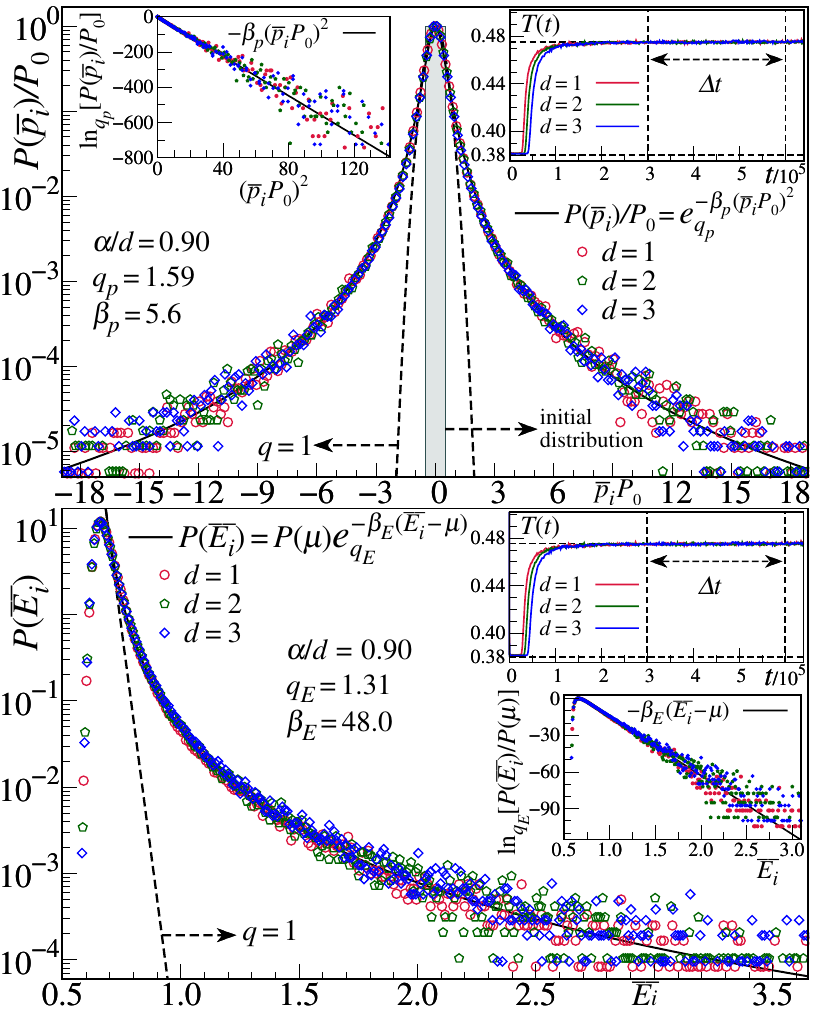
Figure 14. Distributions of the time-averages of the momenta ¯ p i and of the energies ¯ E i (with τ = 1) for α / d = 0.9, in d = 1, 2 and 3 dimensions. The simulations were done for the energy per particle u = 0.69 and total number of rotators N = 10 6 . Top : Distribution P ( ¯ p i ) is shown ( P 0 ≡ P ( ¯ p i = 0 ) ), the full line being a q -Gaussian with q p = 1.59 and β p = 5.6, and the dashed line being a Gaussian ( q = 1 ) . The left inset shows the same data in a q -logarithm versus squared-momentum representation; a straight line is obtained as expected (since ln q ( e x q ) = x ). Bottom : The full line represents the q - [ − β ( ¯ E − µ )] , with q = 1.31 ( β = 48.0, µ = 0.69, and P ( µ ) = 12); exponential P ( ¯ E i ) = P ( µ ) exp E E E i q E the corresponding exponential (dashed line) is also shown for comparison. Since the density of states is necessary to reproduce the entire range of data, a chemical potential µ was introduced in the fitting. The bottom inset shows a straight line by using the q -logarithm in the ordinate. The kinetic temperature T ( t ) ≡ 2 K ( t ) / N and time window ∆ t , along which the time averages were calculated, coincide in both cases (shown as insets). One notices that, in all plots, the collapse of all dimensions occurs with nearly the same value of q . From